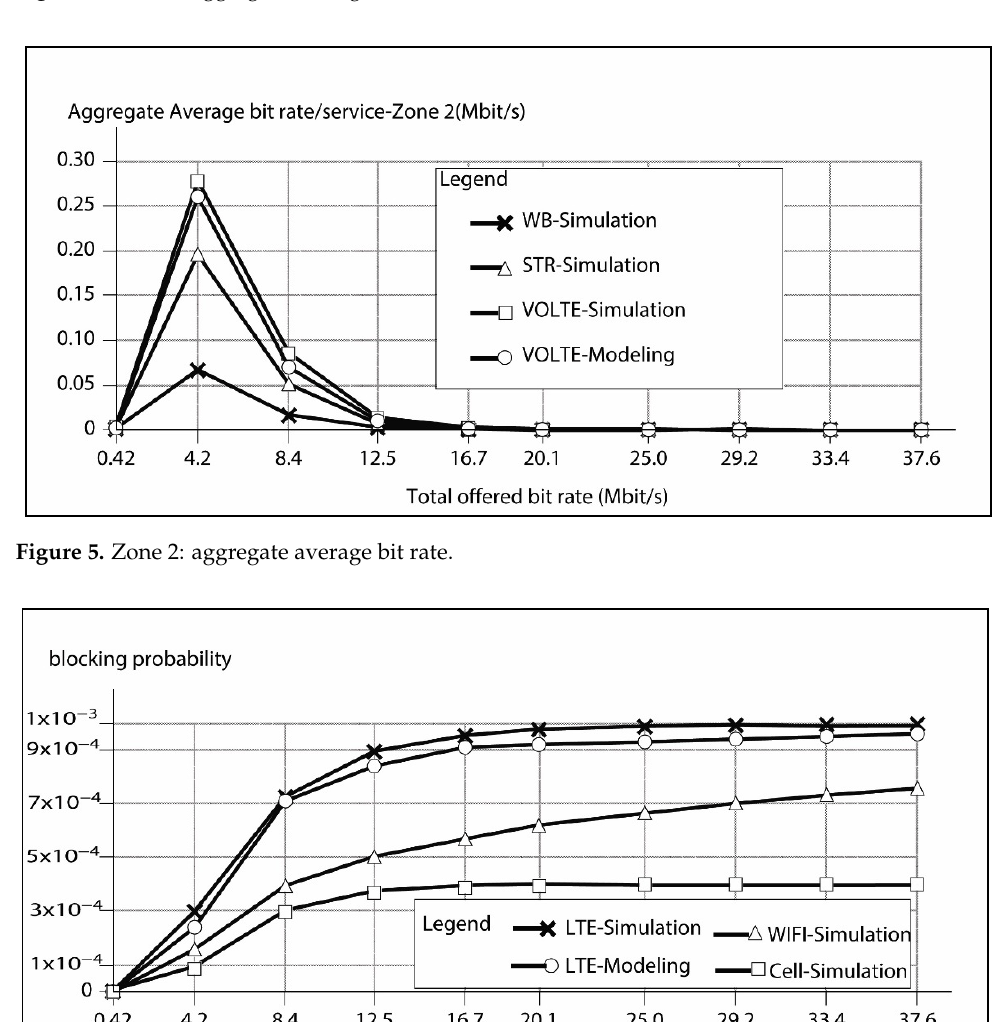
Figure 5. Zone 2: aggregate average bit rate.